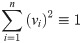
Outline of experimental design and analysis.A) 2 x 2 experimental design of the animal food with 2 different base diets supplemented with 20% fructose in the drinking water. The 2 x 2 design allows analysis of fructose-induced DE effects on both normal- and high-salt base diets. These results are designated as ΔF(NS) and ΔF(HS), respectively. It also allows an analysis of expression changes due to consumption of different base diets, both in the absence or presence of supplemental fructose. The results from this type of analysis are designated as ΔS(-F) and ΔS(+F), respectively, because the normal-salt diet is used as control. B) Transcriptome analysis scheme to extract a fructose-specific DE vector (signature) by the multivariate CD method (upper analysis flow) and generate gene lists by the univariate methods of ANOVA and BAM (lower analysis flow). The multivariate and univariate methods result in different types of primary data (middle column): CD generates a vector with a DE value (vi) for each gene, which is normalized so that ∑i=1n(vi)2≡1. The univariate methods of ANOVA and BAM generate lists of DE genes, depending on the cut-off criteria (e.g., p ≤ 0.05 for ANOVA). To find fructose-specific DE that is common to both base diets, the information from ΔF(NS) and ΔF(HS) is combined. With CD, a gene vector ΔF(common) is created with DE values as geometric means of those of ΔF(NS) and ΔF(HS). The genes with the top most DE values, low enough variance, and similar effects on the two base diets are extracted to yield CD ΔF(signature) as detailed in Fig 2. In the univariate methods, genes with fructose-specific DE are identified by applying the significance criteria simultaneously to both ΔF(NS) and ΔF(HS) and omitting genes with changes in opposite direction. Those fructose-specific genes identified by ANOVA and BAM that are part of the fructose-specific CD ΔF(signature) are then mapped onto this signature, i.e., located on the vector CD ΔF(signature) (last column).